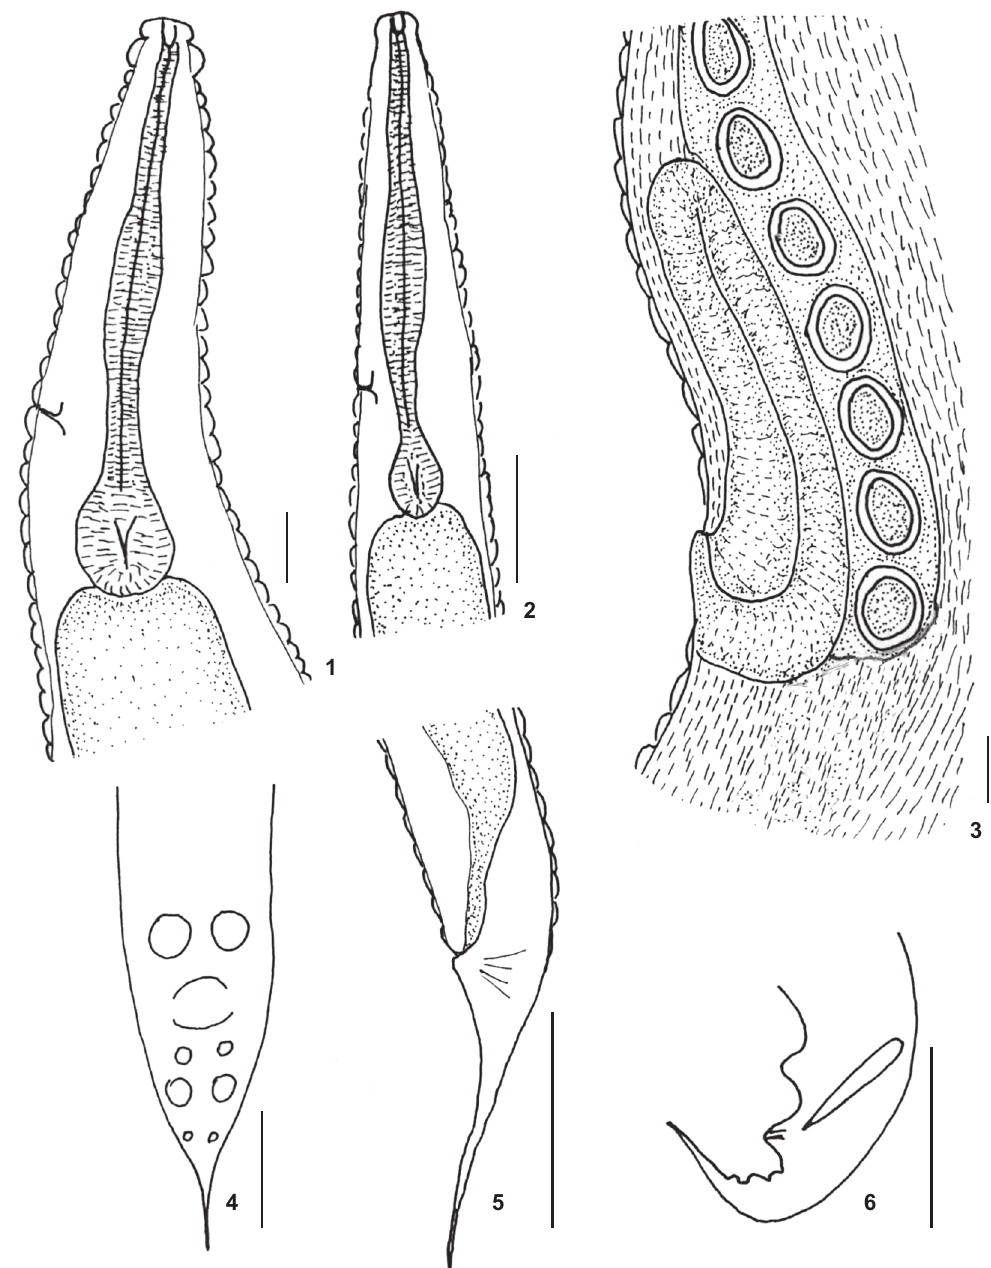
Figures 1-6. Oryctophila bonaerensis sp. nov. : (1) anterior end of the female; (2) anterior end of the male; (3) vagina, uterus with eggs; (4) posterior end of the male, ventral view; (5) posterior end of the male; (6) lateral view posterior end of the female; Scale bars = 50